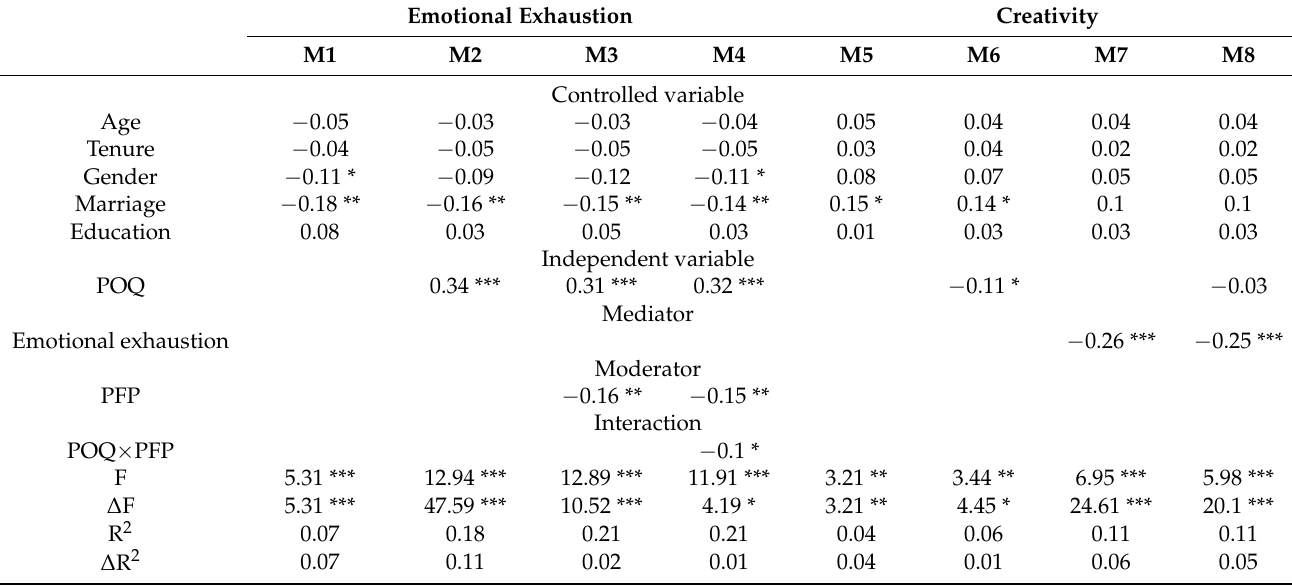
Table 5. Results of hierarchical regression